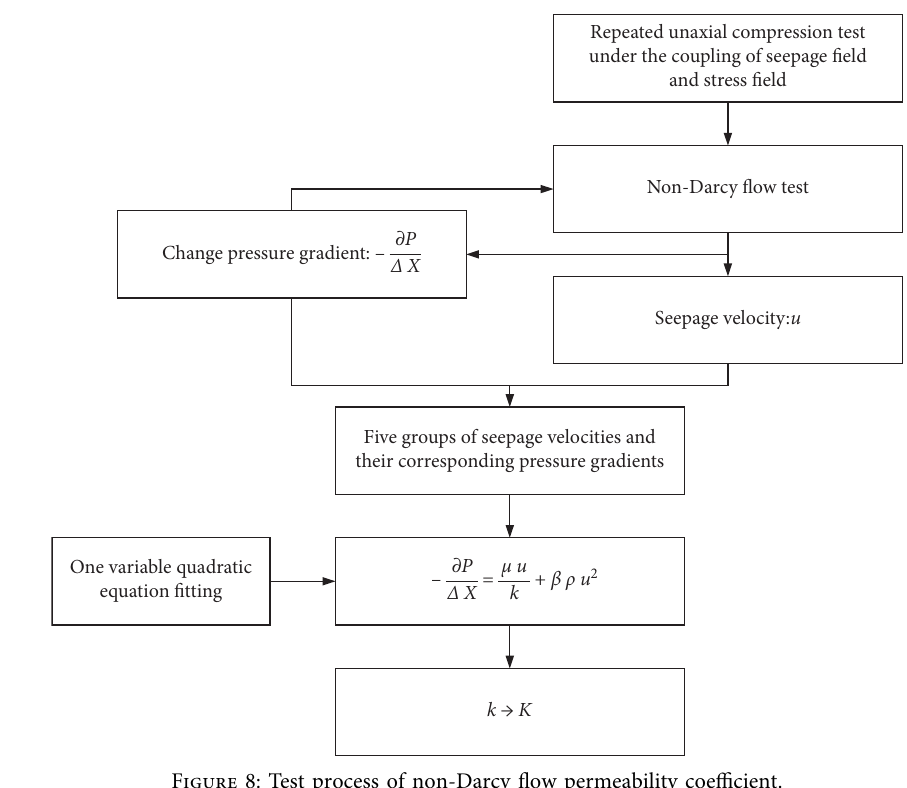
Figure 8: Test process of non-Darcy flow permeability coefficient.